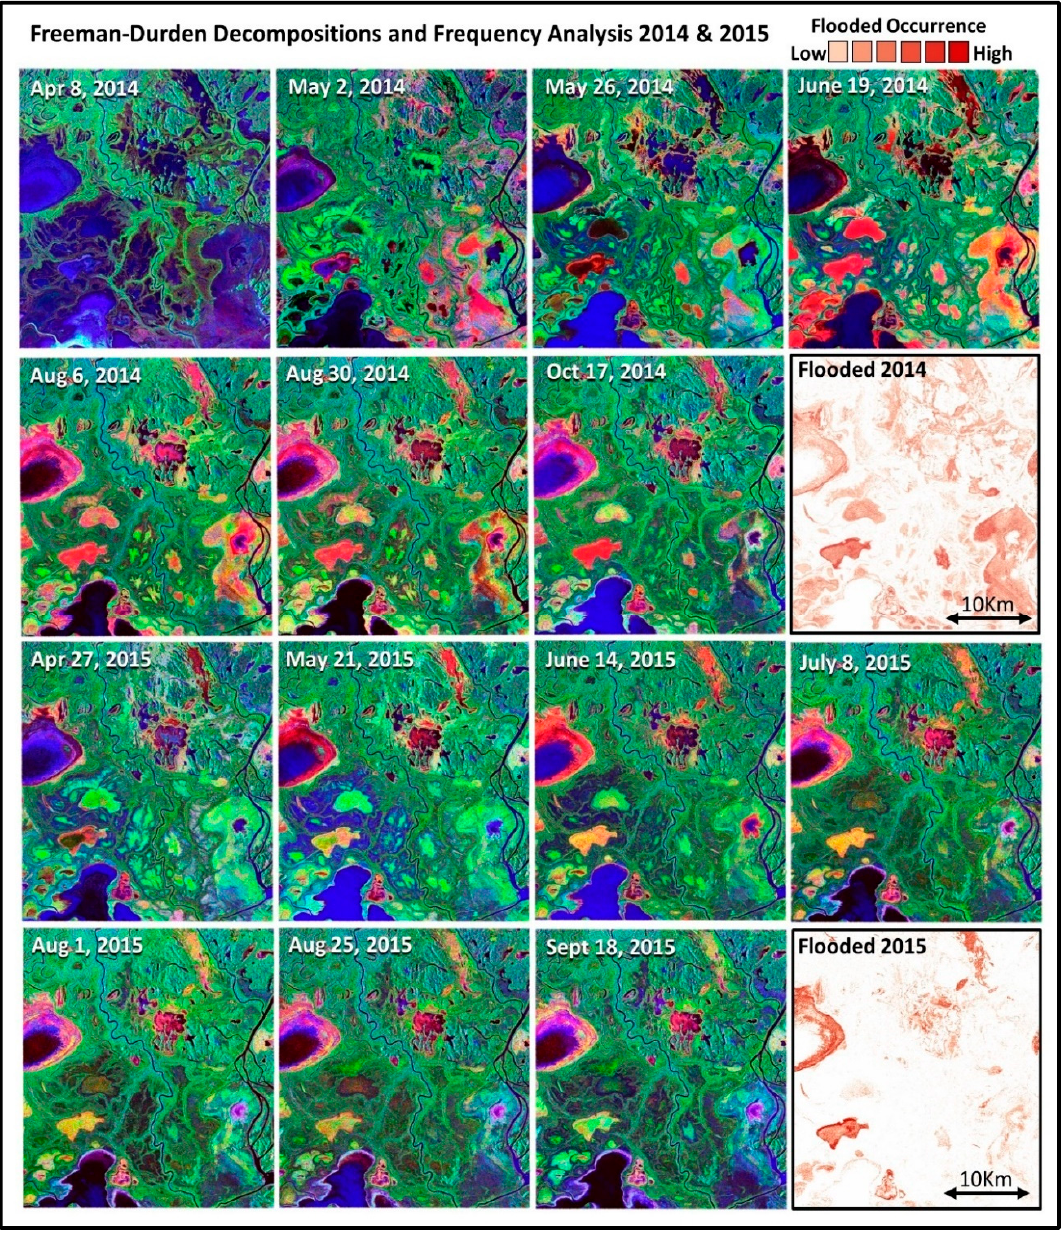
Figure 6. Freeman–Durden decomposition results for 2014 and 2015 and frequency maps indicating duration of flooding for each respective year, where darker red indicates areas with flooded or emergent vegetation for a longer duration throughout the growing season. In the composite images, the power contribution of each scattering mechanism is shown as follows: double-bounce (red), volume (green), and rough (blue) scattering. Table 6. Comparison of flooded vegetation area and duration in months for 2014 and 2015.